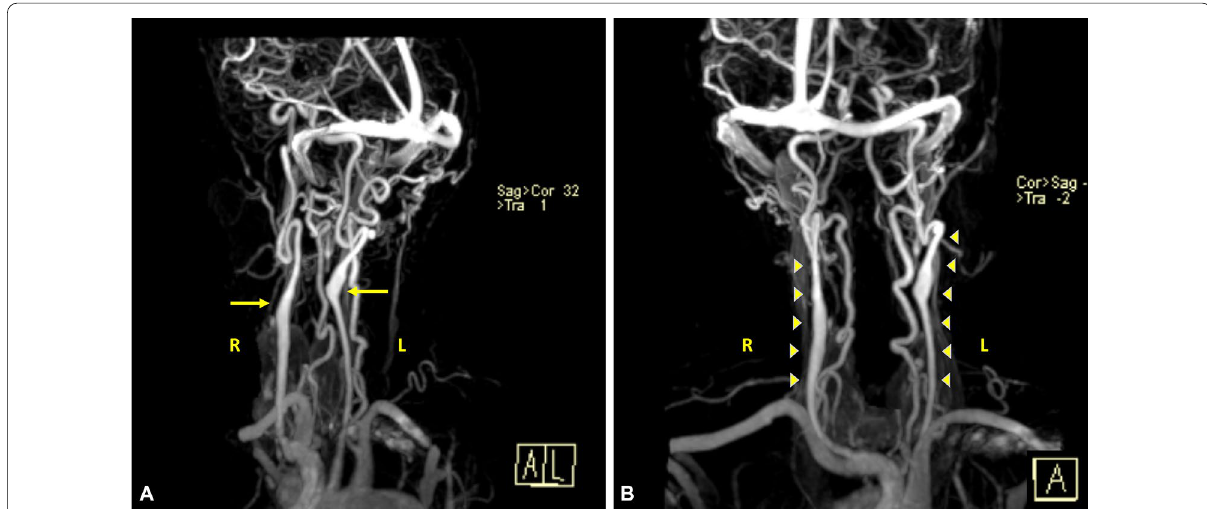
Fig. 2 Neck MRA showing non‑bifurcating carotid arteries. Anterolateral coronal view of neck MRA showing the common carotid arteries and the internal carotid arteries bilaterally originating from the carotid bulbs (arrows; a ). Both vertebral arteries were visualized with high tortuosity. The common carotid arteries ascended in the neck as single carotid vessels without undergoing bifurcation and continuing as internal carotid arteries (arrowheads, b